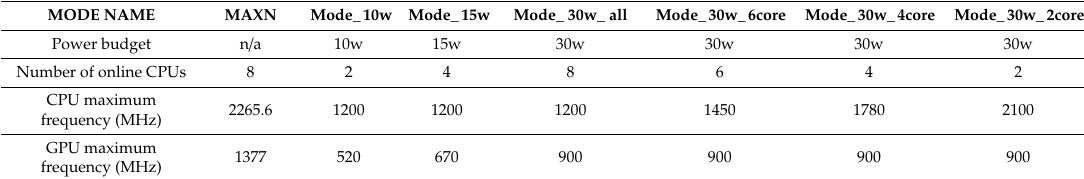
Table 8. Seven working modes of NVIDIA Jetson Xavier.